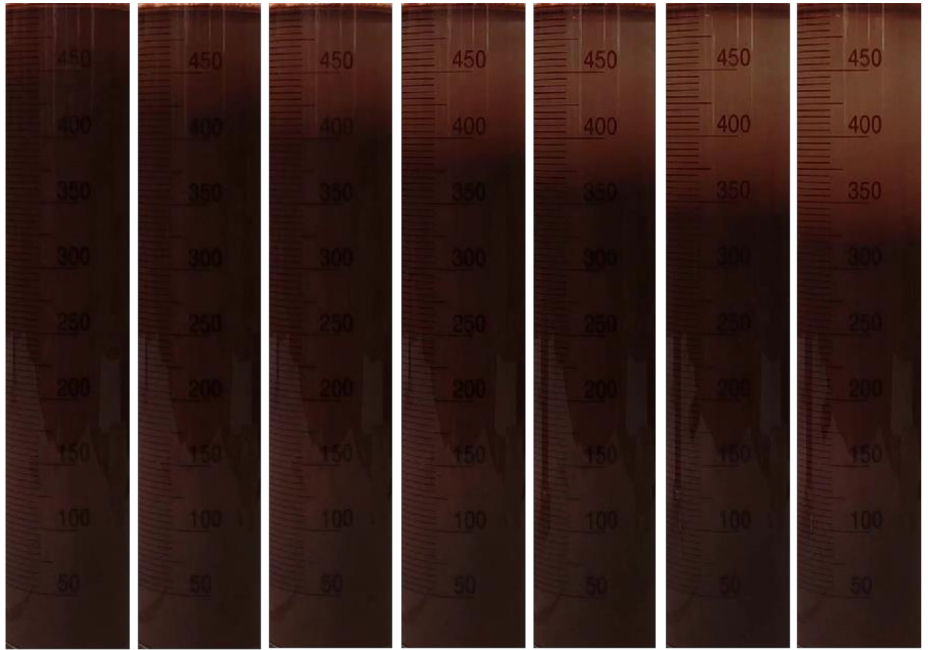
Figure 1. Schematic diagram of the settlement